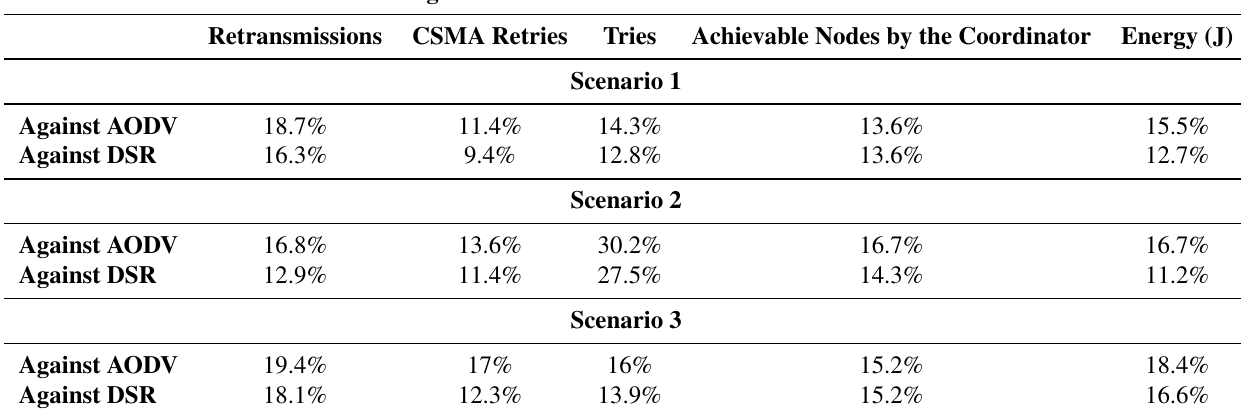
Table 15. Better performance of the MPH protocol against AODV and